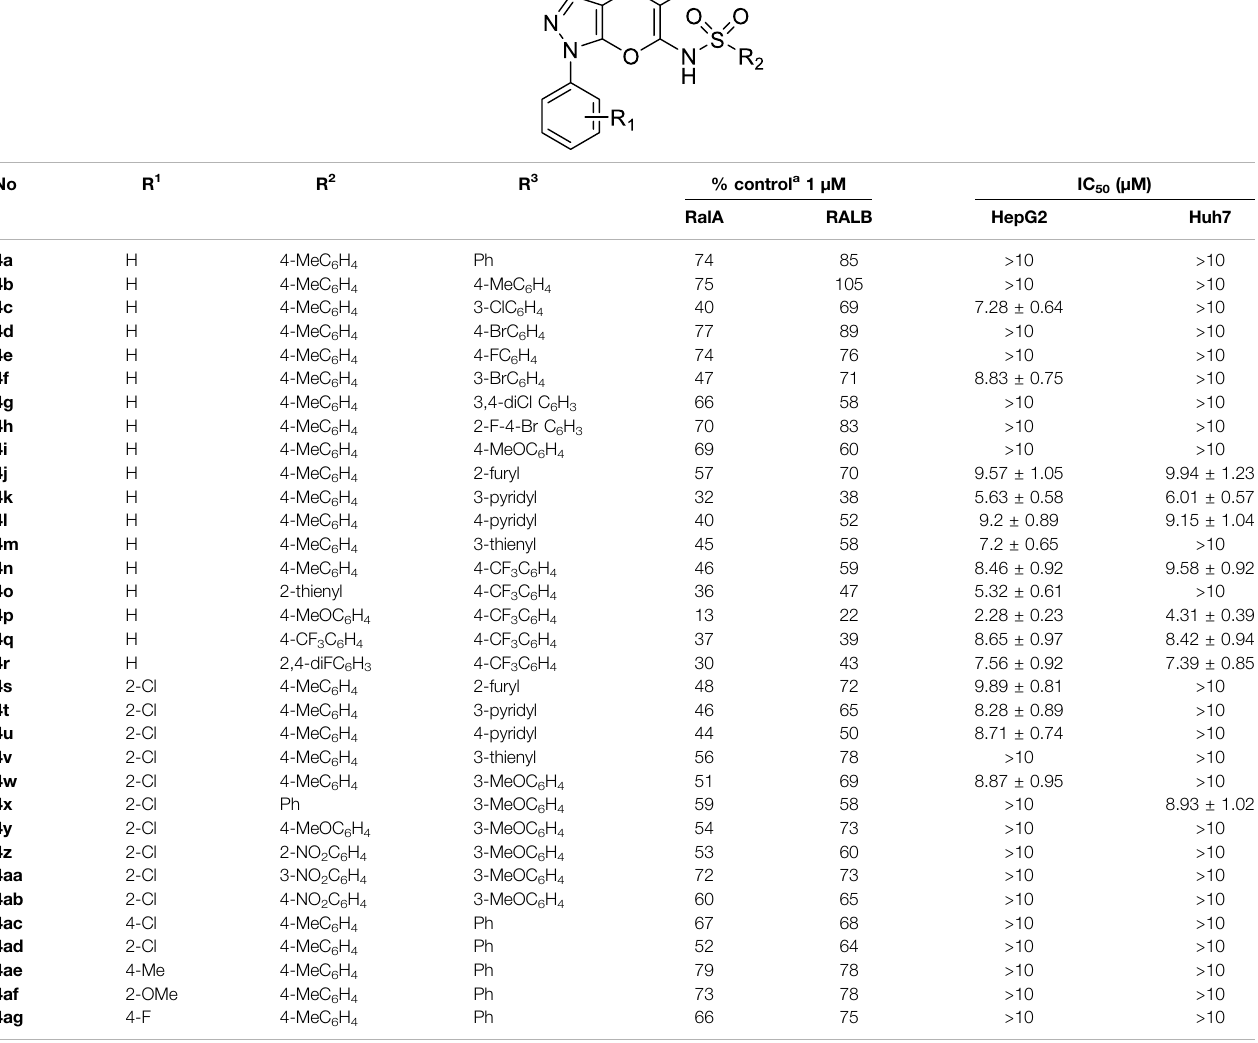
TABLE 1 | Remaining kinase activities (%) after 1 μ M compounds 4a – 4ag incubation on RalA and RalB and cell proliferation